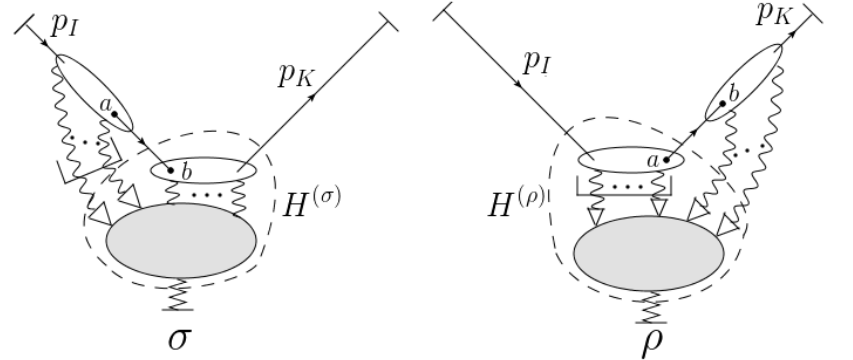
(cid:27) ) T J ( H (cid:26) ) . The shadowed area is the subgraph I; phys K; phys